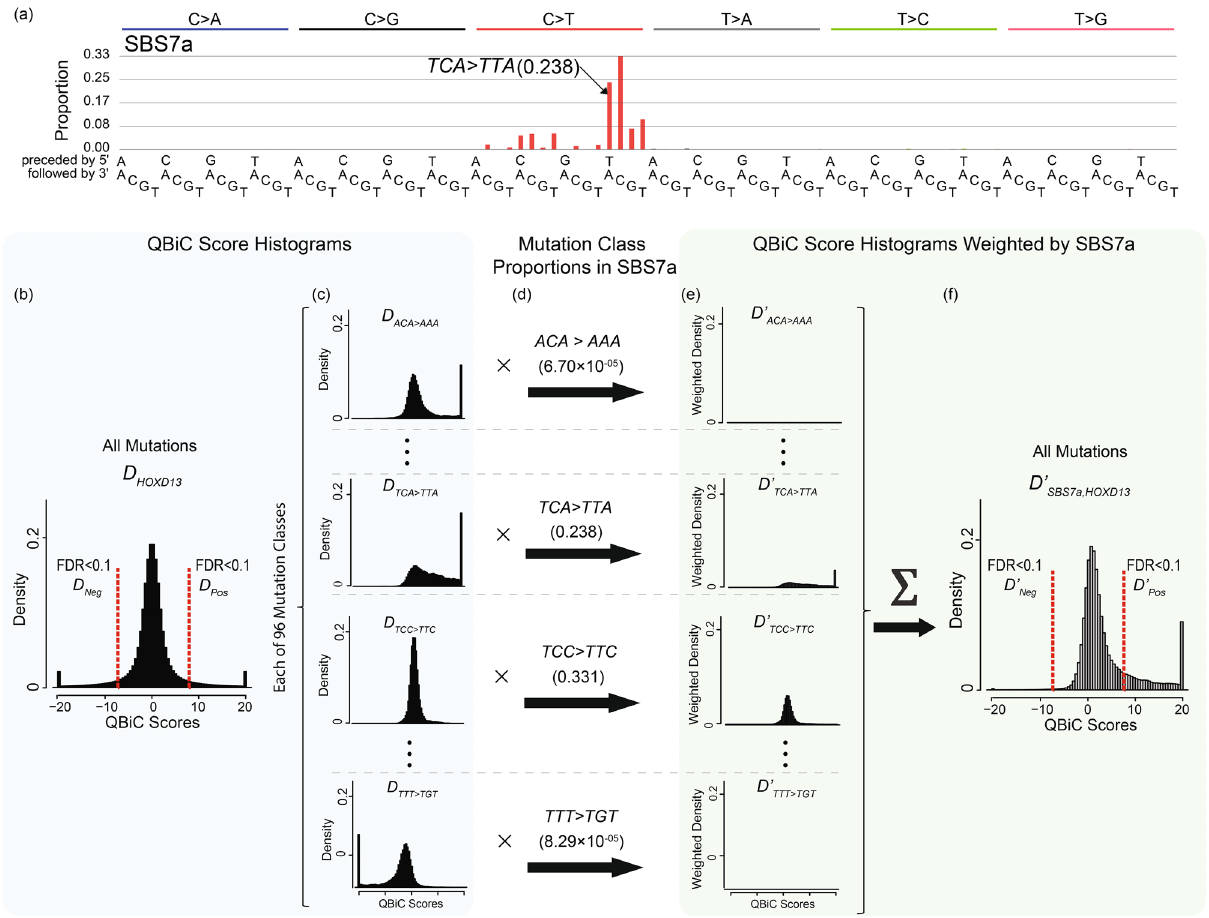
Figure 1. Predicting the effect of mutations due to UV exposure, which generates mutational signature SBS7a, on HOXD13 binding affinity. ( a ) Visualization of mutational signature SBS7a. Central mutations (e.g. C>A) are listed along the top of the xaxis, and source trinucleotides for 96 mutation classes are indicated along the bottom. The height of each bar represents the proportion of mutations due to a particular mutation class. For example, the proportion of TCA>TTA mutations (indicated) is 0.238. ( b – f ) Signature-QBiC analysis. ( b ) D HOXD 13 is the histogram of HOXD13 QBiC scores for all 6,291,456 possible 11-mer changes over all possible central trinucleotides. Because there are long tails of extreme QBiC scores, we display the QBiC scores with absolute value ≥ 20 as single bars at the extreme tails of the histogram. ( c ) D HOXD 13 can be decomposed into histograms for each of the 96 mutation classes. Only 4 example mutation classes out of the 96 classes are shown: ACA>AAA ( D ACA > AAA ), TCA>TTA ( D TCA > TTA ), TCC>TTC ( D TCC > TTC ), and TTT>TGT ( D TTT > TGT ). ( d ) We multiply each histogram in ( c ) by the proportions of the corresponding mutation classes in